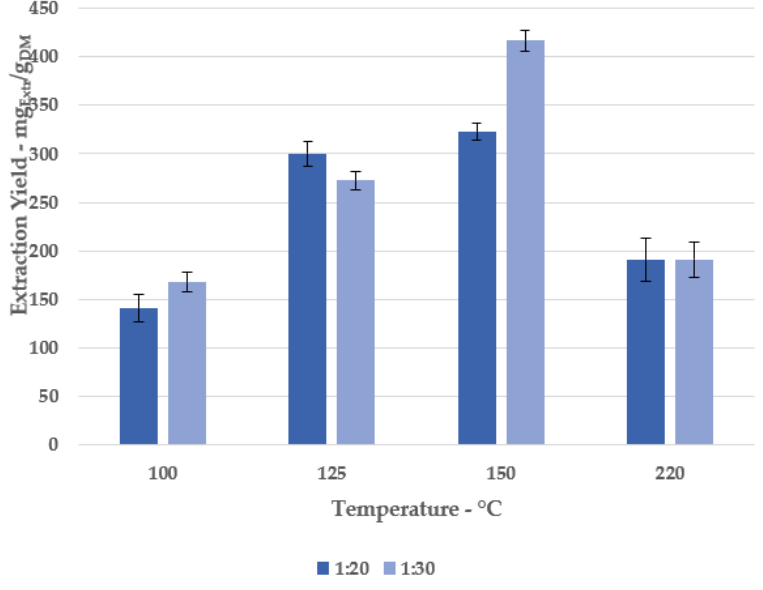
Figure 2. Extraction yields at different solid/liquid ratios and temperatures.